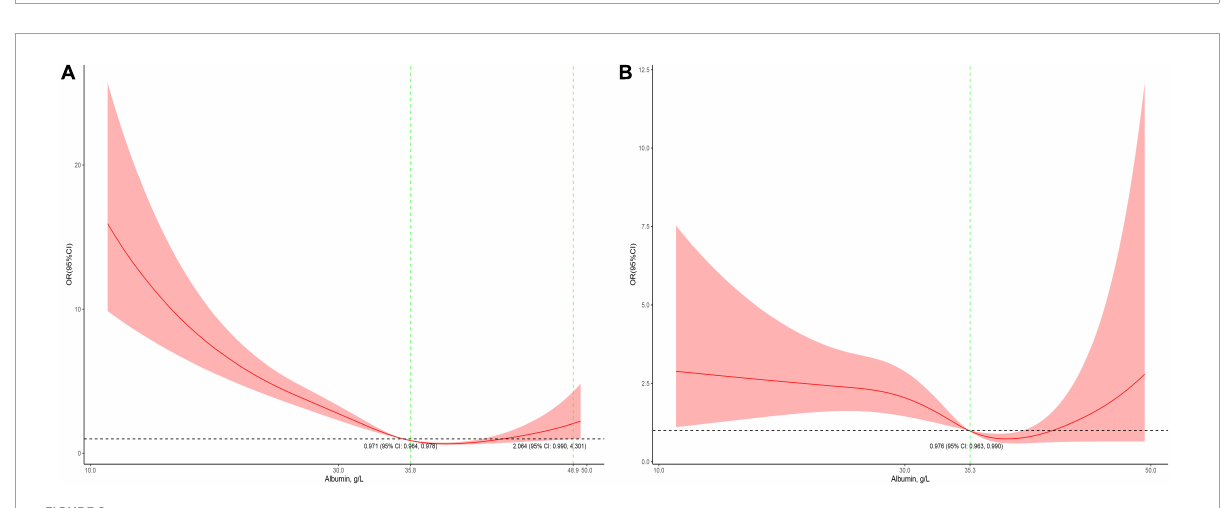
FIGURE2 Association between the lowest serum albumin levels during the PICU stay and mortality in all patients ( A, the crude model; B, the model adjusted for age, race, sex, admission form emergency department, cardiac surgery, PO 2 , PCO 2 , shock index, RR, bilirubin, eGFR, mechanical ventilation, inotropes, AKI, and PRISM). The 95% CI included an OR of 1.0 at albumin concentrations between 35.8 and 48.9 g/L in the crude model and > 35.3 in the adjusted